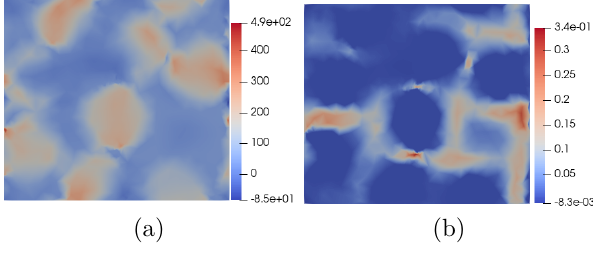
Figure 11. Basalt composite with minimal stiffness, time = 50 s: a) Shear stress [MPa], b) creep strain.